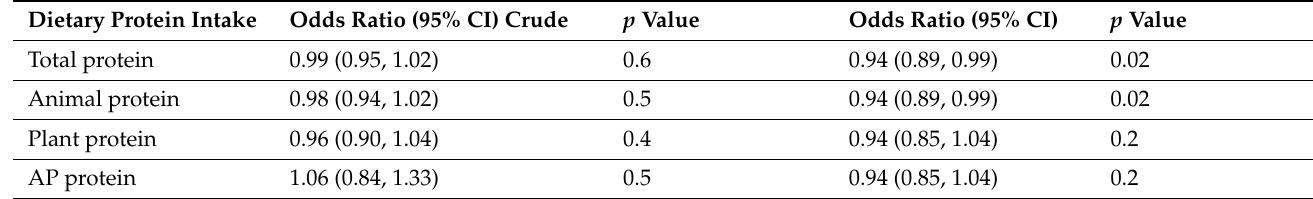
Table 2. Association between dietary protein intake and metabolic syndrome in AHS-2 calibration study ( n =